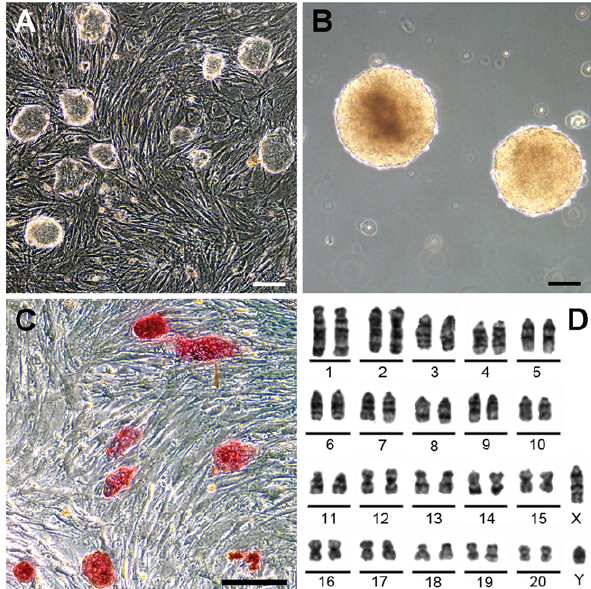
Figure 1. Verification of M13 rat iPSC characteristics. A, Mouse embryonic stem cell-like colonies of M13 cells on a feeder layer. B, Embryoid bodies on day 6 of a floating culture of M13 cells. C, Alkaline phosphatase staining of M13 colonies. D, M13 cells maintain a normal diploid karyotype of male rat origen (42XY) at passage 31. Scale bars: 100 m m.